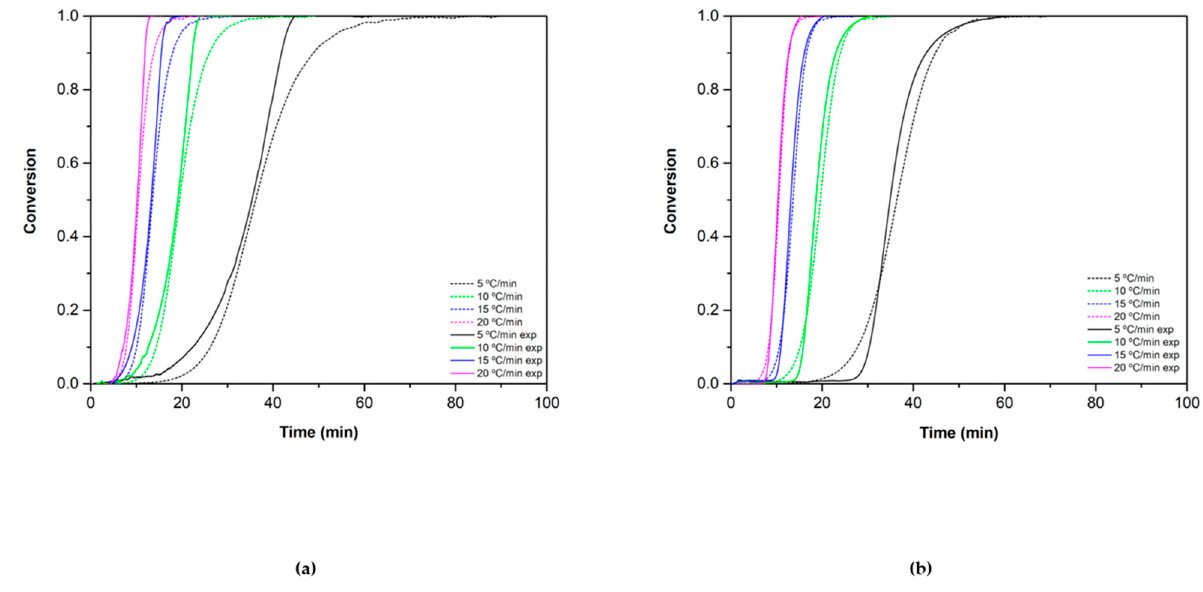
Figure 10. Reduction conversion validation for ( a ) Co 2.4 Ni 0.6 O 4 and ( b ) 0.5% SiO 2 /Co 2.4 Ni 0.6 O 4 . The dotted lines correspond to the theoretical values and the solid ones to the experimental ones.